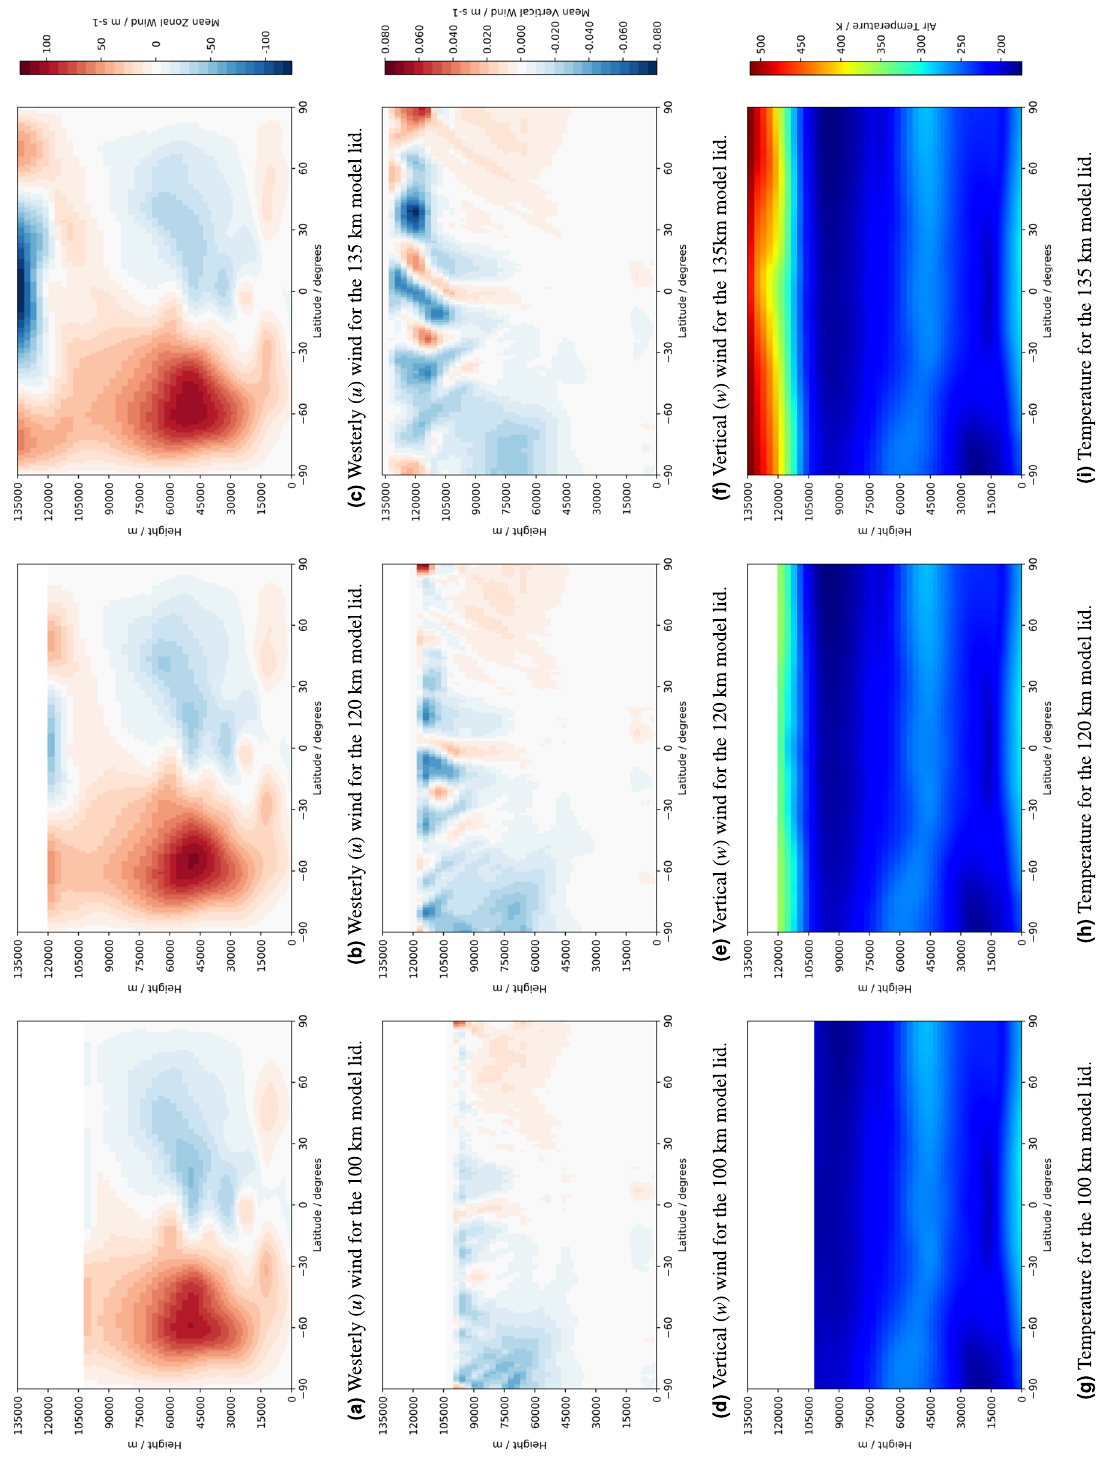
Fig. 19. Zonal mean monthly mean climatologies in June of westerly ( u ) wind (top), vertical ( w ) wind (middle) and temperature (bottom) comparing the nudged 100 km model run with the successful 120 and 135 km lid model